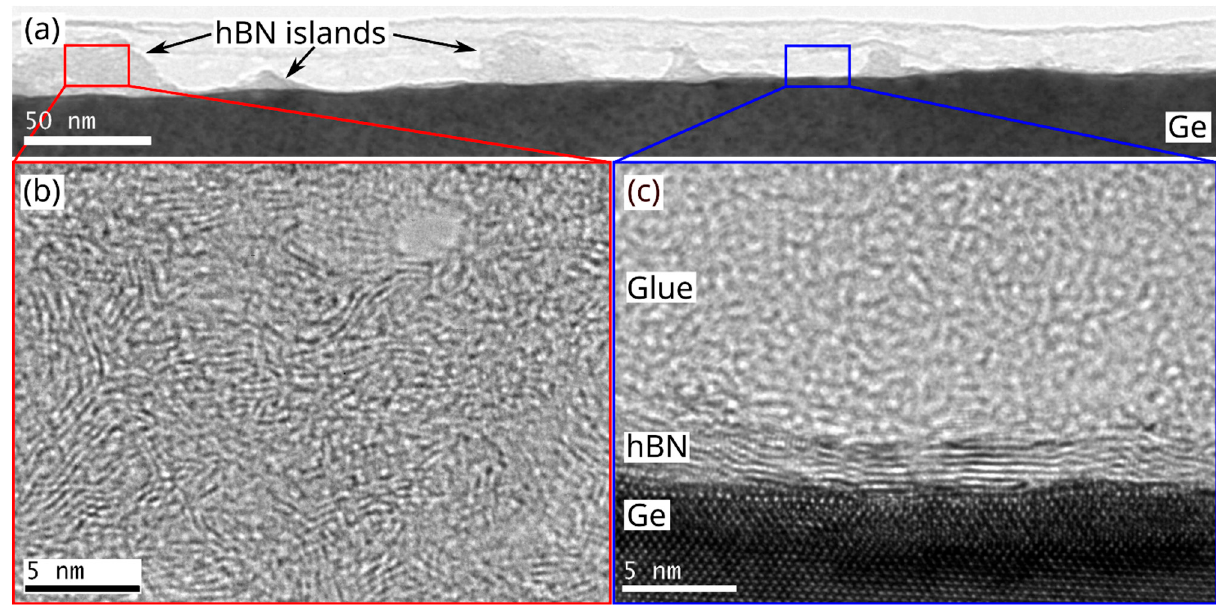
Figure 6. ( a ) Overview TEM image of sample grown at 980 °C, showing islands and flat regions; ( b ) detailed view of island marked by red box in ( a ); ( c ) detailed view of vertically stacked hBN layers between islands marked by blue box in ( a ).